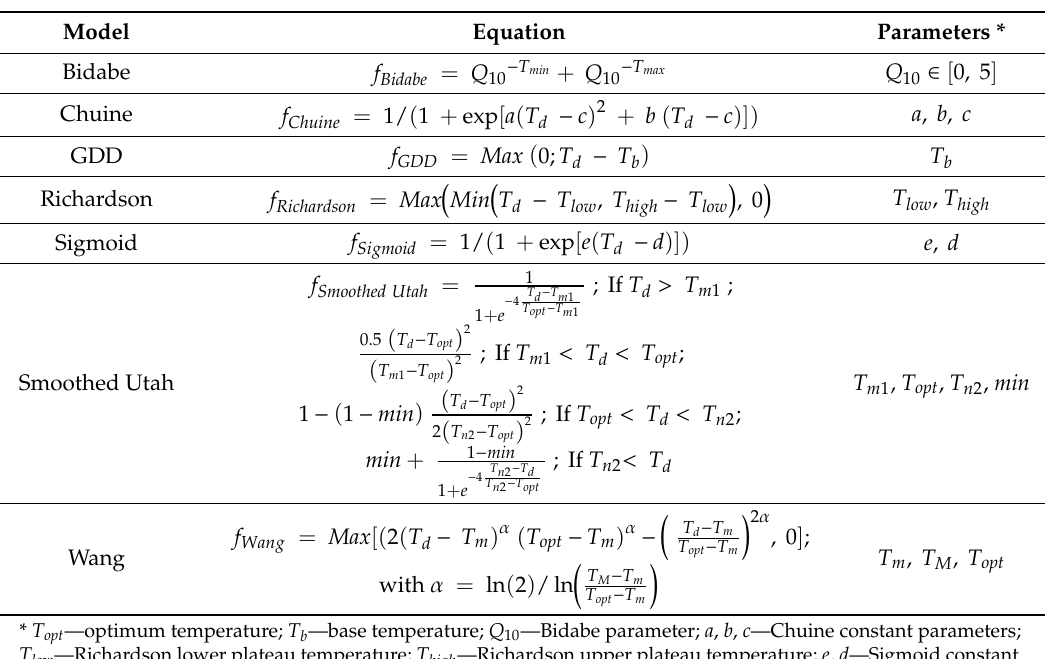
Table 3. Grapevine phenology models selected in the present study, accompanied by their transfer function equations as a function of daily mean ( T d ), maximum ( T max ) and minimum ( T min ) temperatures. The corresponding parameters are also